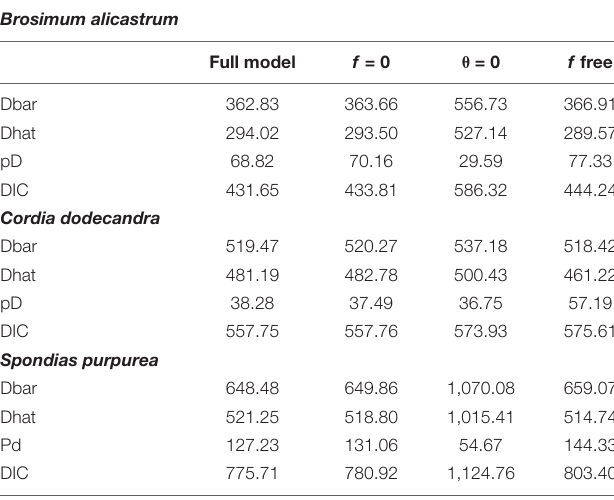
Data estimated from ISSRs markers in three species of multipurpose trees from Yucatan, Mexico.